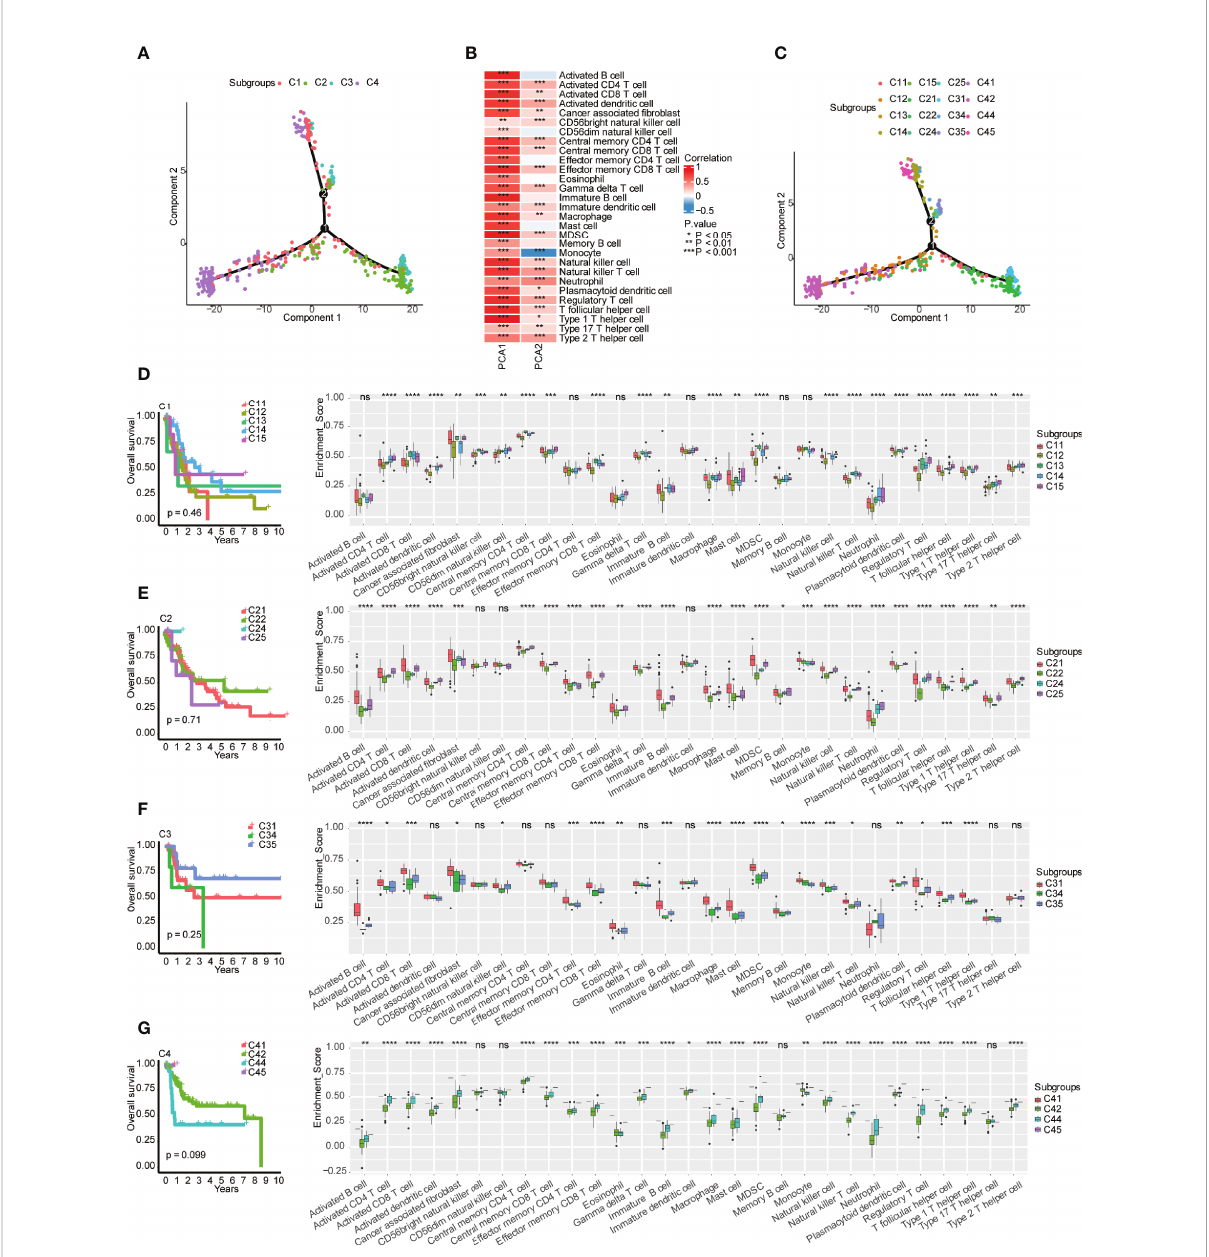
FIGURE 6 Immune gene-related landscape of bladder urothelial carcinoma. (A) Distribution of patients after reduced dimension. (B) Correlations between principal component analysis and immune cells. (C) Distribution of patients representing the status of each immune subtype. (D – G) Strati fi cation analysis of immune subtypes. (D) Prognostic value and immune cell components in different subgroups of the C1 subtype. (E) Prognostic value and immune cell components in different subgroups of the C2 subtype. (F) Prognostic value and immune cell components in different subgroups of the C3 subtype. (G) Prognostic value and immune cell components in different subgroups of the C4 subtype. , ns, p ≥ 0.05; *p < 0.05; **p < 0.01; ***p < 0.001; and ****p <